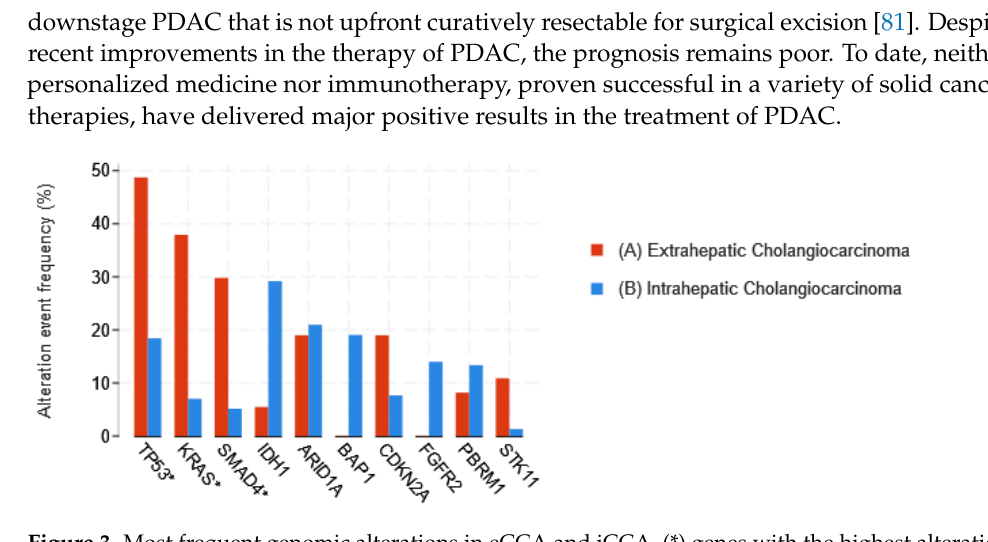
Figure 3. Most frequent genomic alterations in eCCA and iCCA, (*) genes with the highest alteration frequency [59] extracted from (http://cbioportal.org (accessed on 16 January 2023)) [70,71].